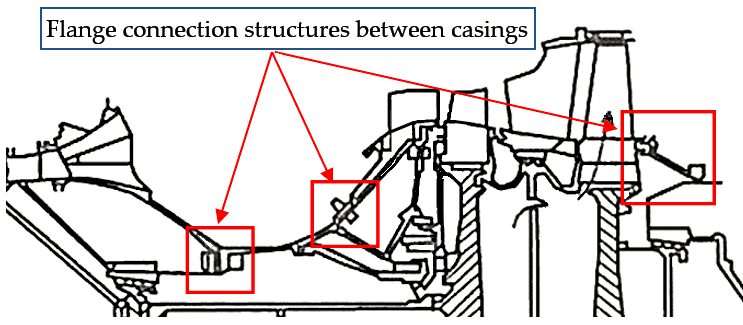
Figure 1. Distribution of typical engine flange connection